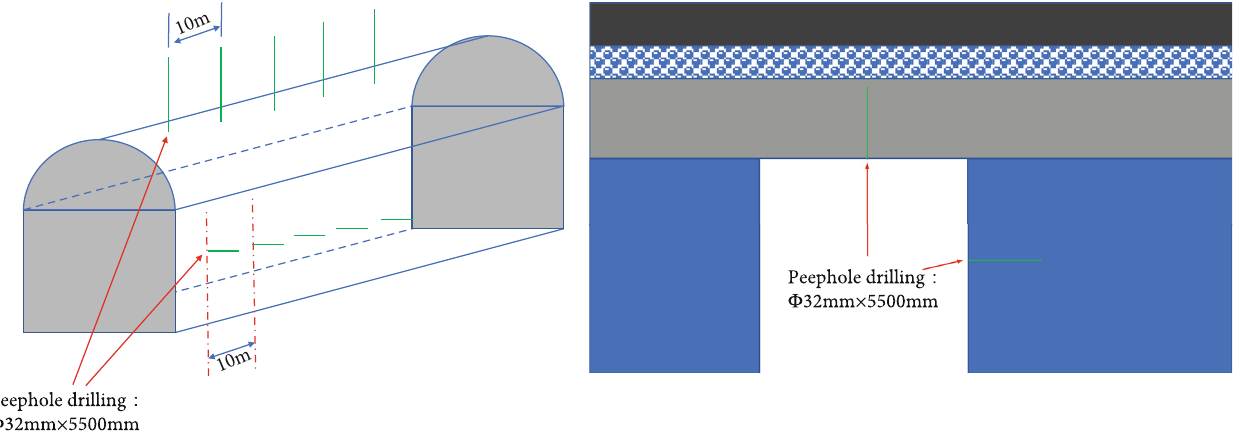
Figure 5: Arrangement of borehole observation